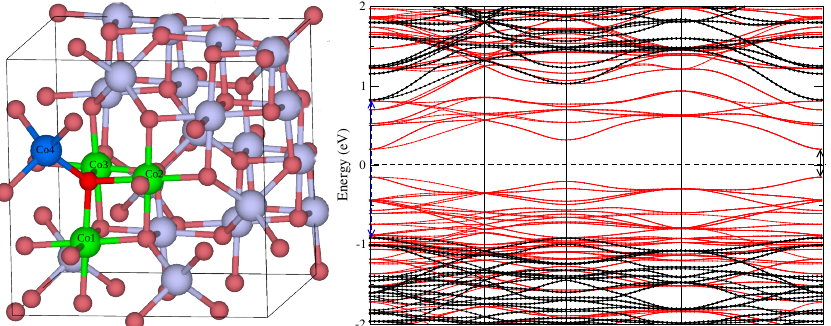
Figure 2. Co 3 O 4 crystal structure and the corresponding bands calculated with the standard GGA (red lines) and GGA + U (black lines) respectively. In the crystal structure, the bluish grey and red spheres represent Co and O atoms, respectively. The bright red sphere represents the photon- absorbing oxygen atom bonded to the cobalt atoms in the local octahedral (green) and tetrahedral (blue) environments. In the bands, the dashed vertical arrow and the solid arrow show the electronic band gaps as obtained with the GGA + U and the GGA functionals, respectively. The arrows are drawn at the band edges which are located at the Γ point of the Brillouin